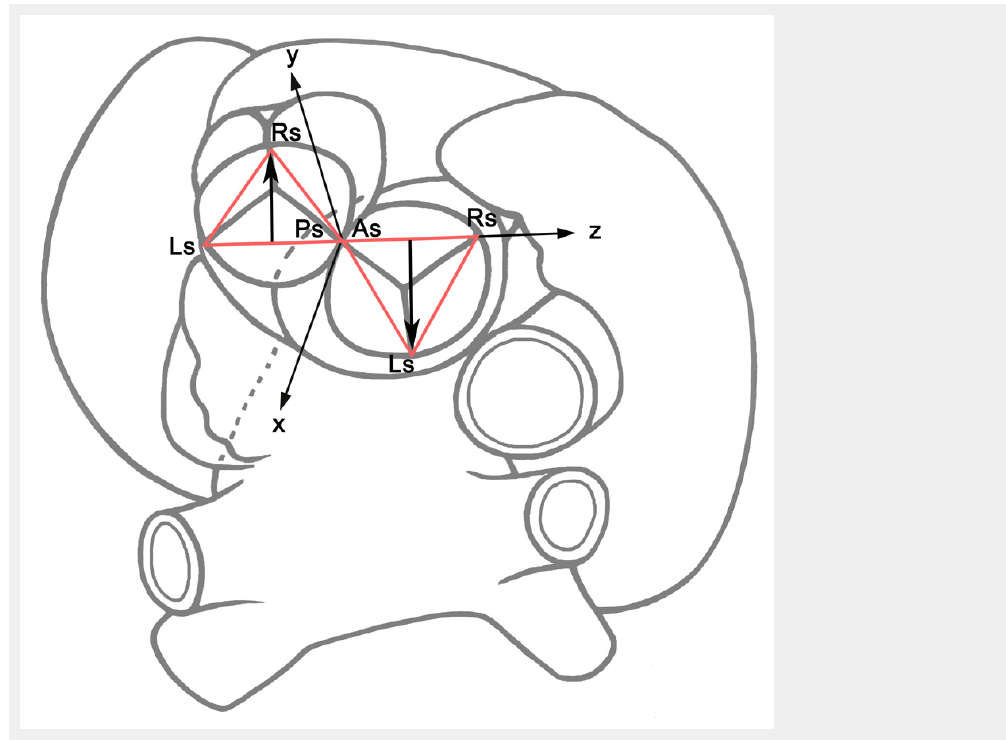
Figure 2 Superior view of the aortic and pulmonary roots. The sinutubular triangles in the aortic (‘ AsRsLs ’) and pulmonary roots (‘ PsLsRs ’) are indicated. The root vectors were positioned parallel to each other in opposite directions. The common frame of reference was positioned with its origin just between the posterior commissure of the pulmonary root and the anterior commissure of the aortic root. The x- axis runs toward the left atrium, the z- axis toward the right auricle, and the y- axis is perpendicular to the ‘ x-z’ plane. Note that the stretch ‘ LsPs ’ of the pulmonary root and the stretch ‘ AsRs’ of the aortic root are positioned along the z-axis. Consequently, the directions of the root vectors are opposite, but